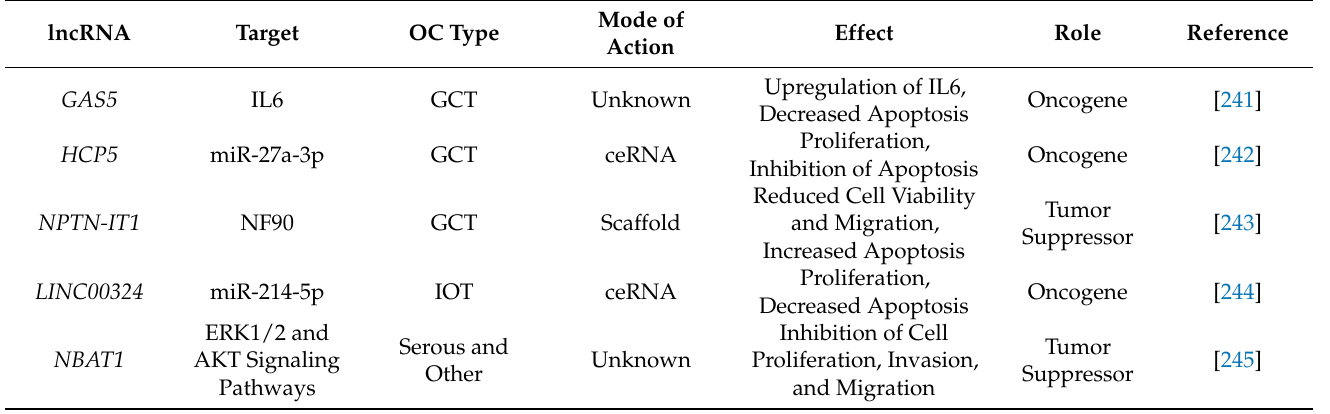
Table 3. Other lncRNAs with a role in ROCs. ROC analyzed in these papers include GCT–granulosa cell tumors, IOT- immature ovarian teratocarcinoma, and undefined